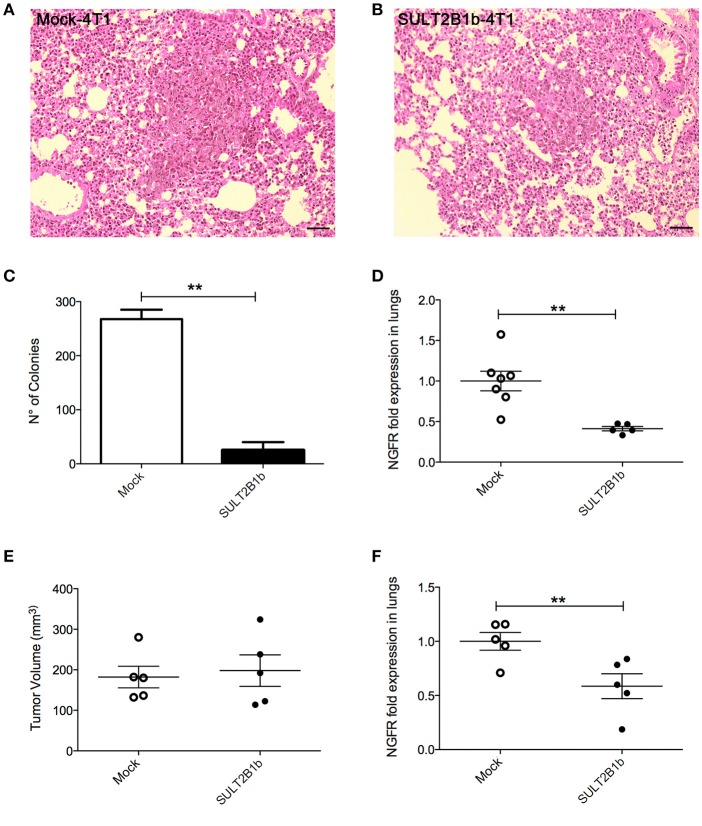
SULT2B1b expression affects in vivo metastatic behaviour of 4T1 tumor cells. (A,B) H&E analysis of Mock-4T1 and SULT2B1b-4T1 lung metastatic nodules. The inflammatory component surrounding the SULT2B1b-4T1 lung metastatic nodule (B) is less dense than that surrounding the Mock-4T1 lung metastatic nodule (A). Original magnification 200x; bar, 100 μm. (C) Clonogenic assay and (D) qPCR analysis of lungs of tumor-bearing mice. (E) Primary tumor growth and (F) qPCR analysis of lungs of tumor-bearing mice, in which Mock-4T1 and SULT2B1b-4T1 primary tumors were surgically removed after reaching the same size. **p < 0.01. (Student's t-test).